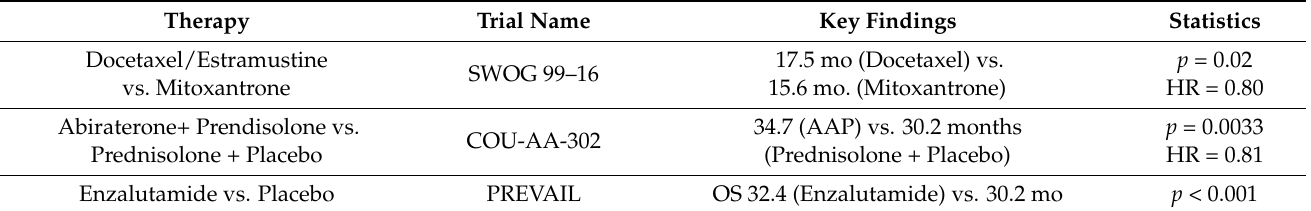
Table 4. Firstline options in